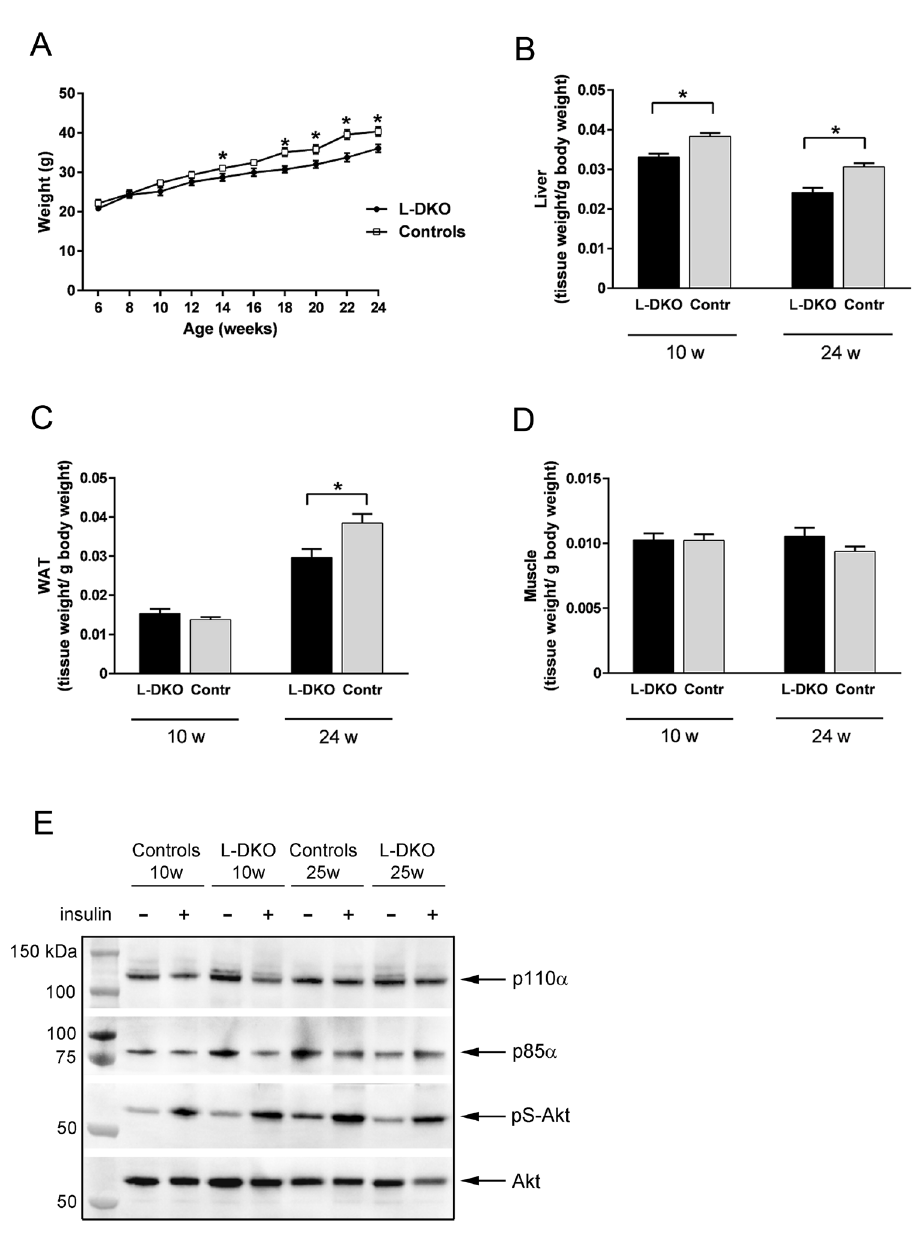
Figure 3. Body weight, tissue weights and adipose insulin signaling. ( A ) whole body weight, ( B ) liver weight, ( C ) white adipose tissue (WAT) weight and ( D ) muscle weight of 10 and 24 week old male L-DKO mice and controls. ( E ) Representative western blot of p110 α , p85 α and phosphorylated Akt/PKB (Ser 473) in WAT of 10 and 25 week old male flox controls and L-DKO mice. Total Akt/PKB was used as a loading control. Basal condition is indicated with a minus (-) sign, insulin-treated condition is indicated with a plus (+) sign. Basal conditions refer to fasting of mice overnight and injection of saline through the vena cava. Insulin treatment refers to injection of 5 U of insulin through the vena cava 5 min prior to euthanization. Error bars indicate SEM (n = 8–17). *, p < 0.05 compared to controls. w =